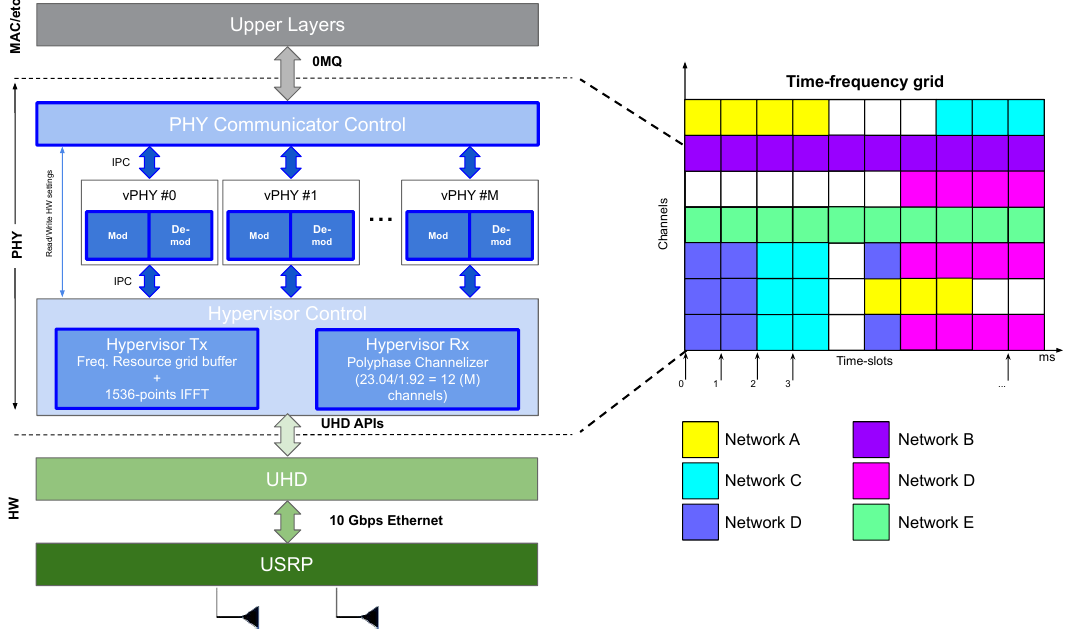
Figure 8. High-level architecture of the implemented